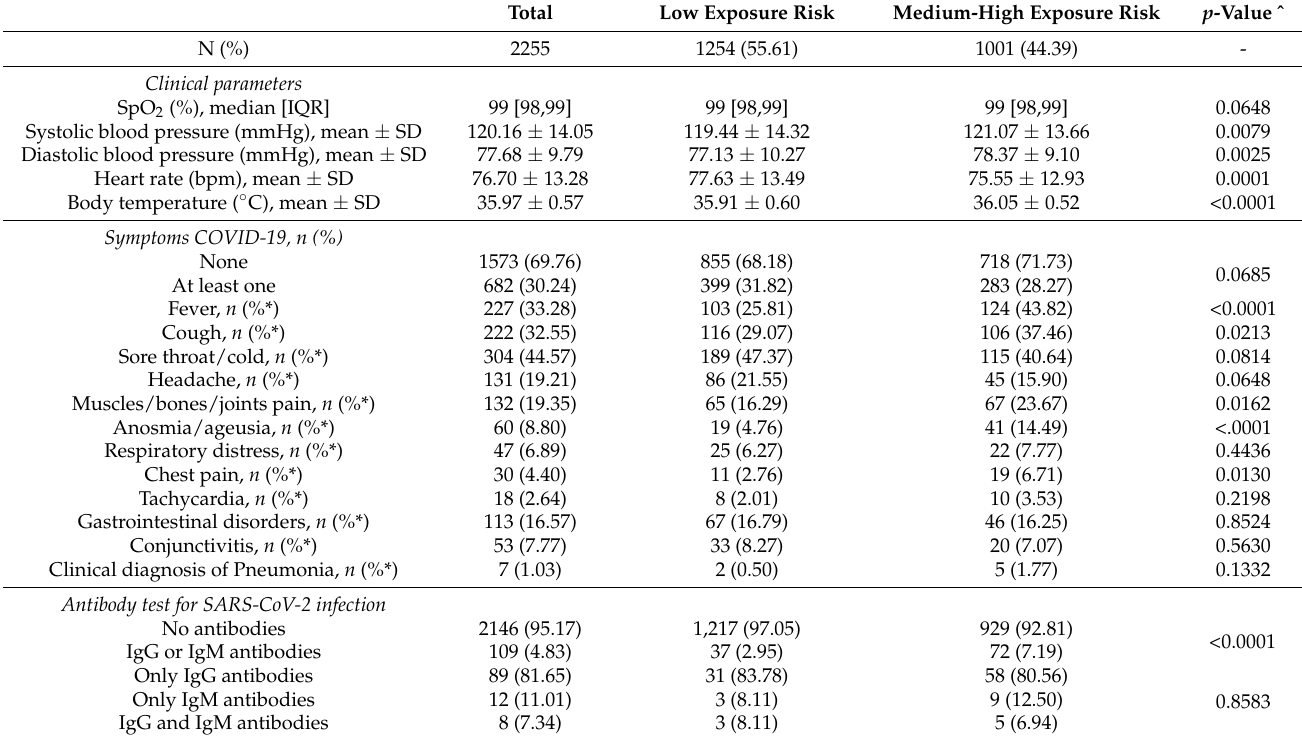
Table 3. Clinical and serological parameters of study population stratified by SARS-CoV-2 exposure level.